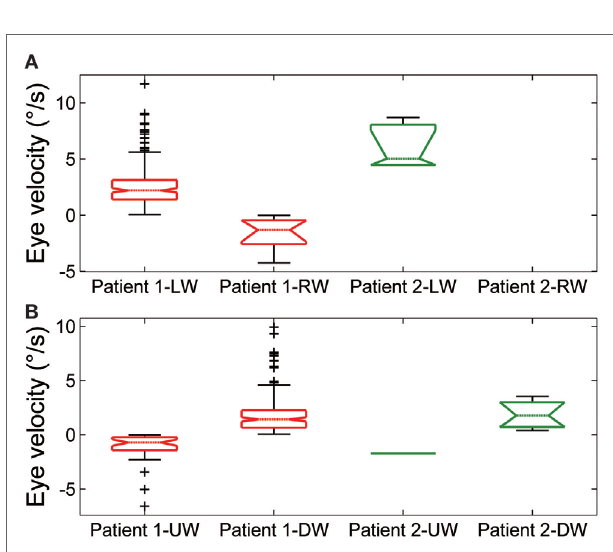
FigUre 5 | Summary of slow phase eye velocity of (a) horizontal and (B) vertical spontaneous jerk nystagmus. The box and whisker plots show the slow phase eye velocity of spontaneous jerk nystagmus in Patient 1 and Patient 2. Rightward (RW) and leftward (LW) horizontal nystagmus and upward (UW) and downward (DW) vertical nystagmus are shown separately for each patient. Box plots as in Figure 3 .